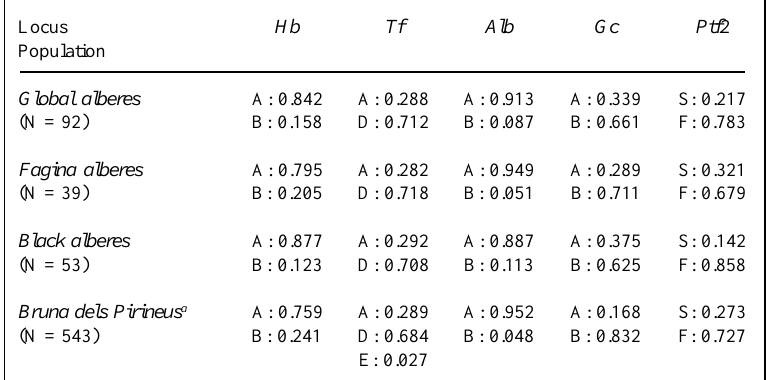
Table I - Allele frequencies for each electrophoretic locus and population analyzed of “Alberes” and “Bruna dels Pirineus” cattle breeds.